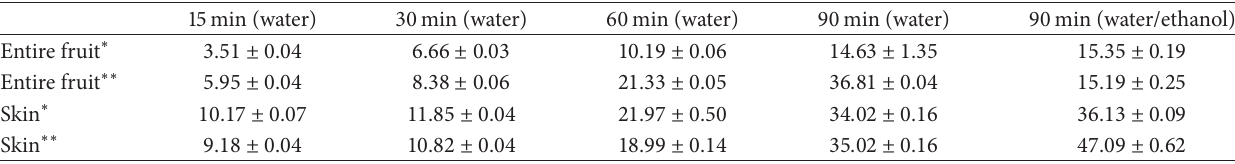
Table 2: Comparison of phenolic content of water extracts and 50% aqueous ethanol extracts of dry entire eggplant and skin at 100 ∘ C at variable heating times, with conventional method or microwave-assisted extraction (MAE). Values are reported in mg gallic acid equivalents ± SD ( 𝑛 = 3 ) on 1.5 g of